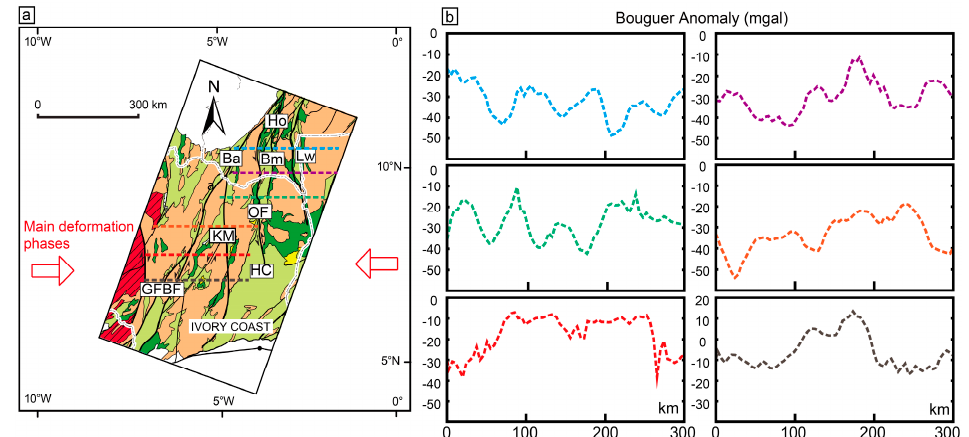
Figure 2. ( a ) Six geological profiles in which the Complete Bouguer gravity anomalies was acquired. ( b ) The Complete Bouguer gravity anomalies collected from the geological profiles (different color lines correspond to the geographic location shown in Figure a).